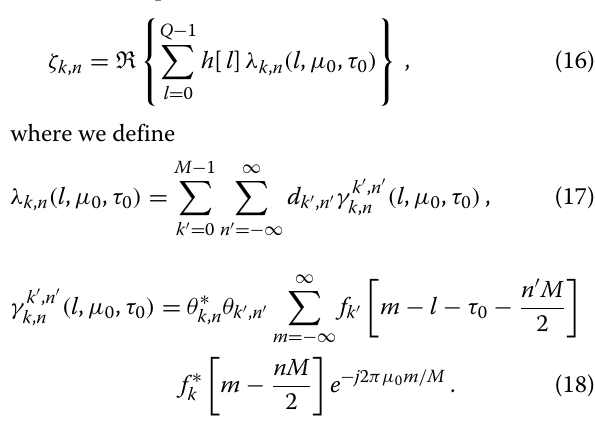
(cid:8) , n (cid:8) ( 0, 0, 0 ) of the OFDM/OQAM system using Bellanger’s (also known as PHYDYAS) filter [41, 42] k , n